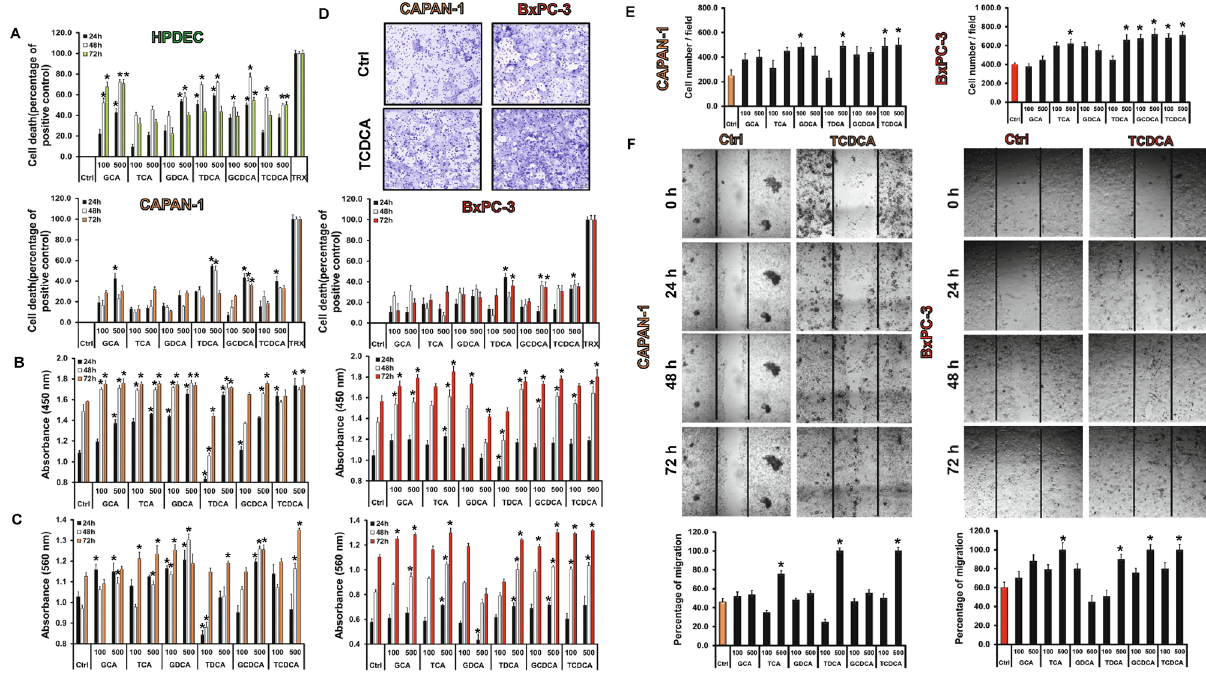
Figure 2. Effects of bile acid treatment on cell viability, proliferation, adhesion, invasion and migration. Capan-1 and BxPC3 cells were exposed to different concentration of bile acids (BAs) for 24, 48 and 72 h and the effects on cellular viability ( A ), proliferation ( B ), adhesion ( C ), invasion ( D , E ) and migration ( F ) were studied using different assays, as described in Materials and Methods. In the case of viability assay, as a positive control, 0.1% Triton-X-100 (TRX) was used. The rate of migration was investigated by the wound healing assay. Photography was taken at 0, 24, 48 and 72 h after TCDCA (500 µM) treatment using Olympus IX83 inverted microscope (Olympus cellSense Dimension software version 2.3, https ://www.olymp us-lifes cienc e.com/en/softw are/cells ens/) and the rate of wound closure was expressed as % of migration at 72 h. Data represent mean ± SEM of three, independent experiments. * = p ≤ 0.05 vs. Control. GCA glycocholic acid, TCA taurocholic acid, GDCA glycodeoxycholic acid, TDCA taurodeoxycholic acid, GCDCA glycochenodeoxycholic acid, TCDCA taurochenodeoxycholic acid. Orange indicates Capan-1whereas red BxPC-3